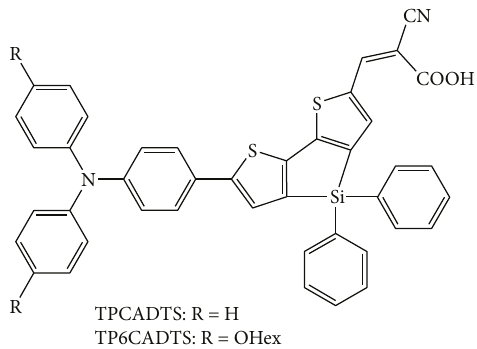
Figure 8: Molecular structures of TPCADTS and